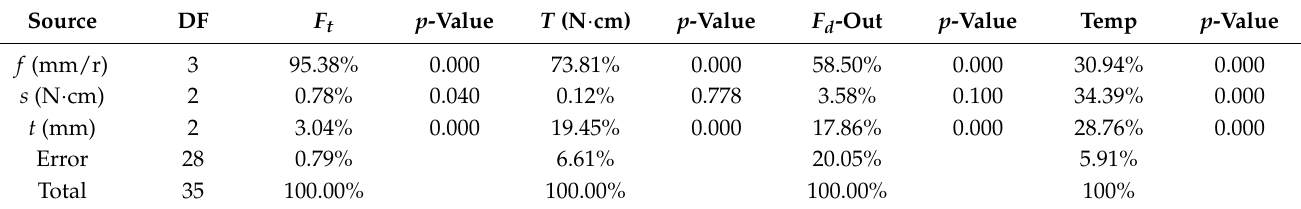
Table 5. ANOVA results with the contribution of control factors’ effect on machinability